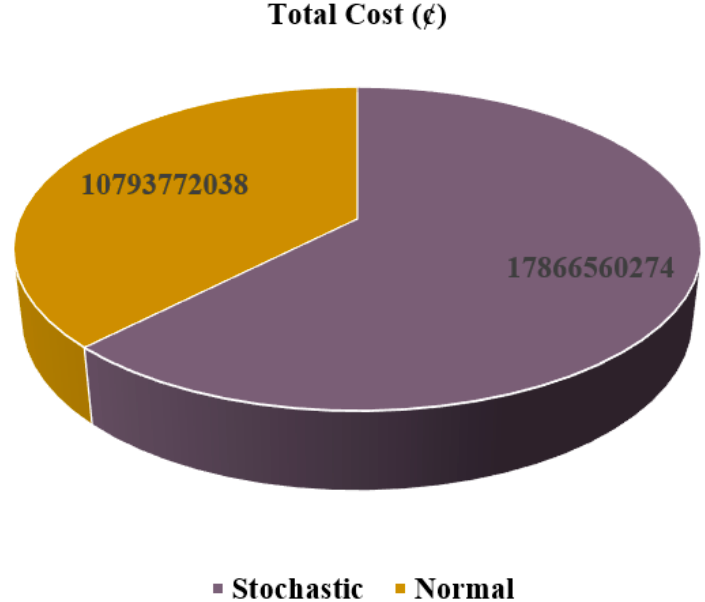
Figure 13. The average energy consumption of mining devices under uncertainty/normal conditions.